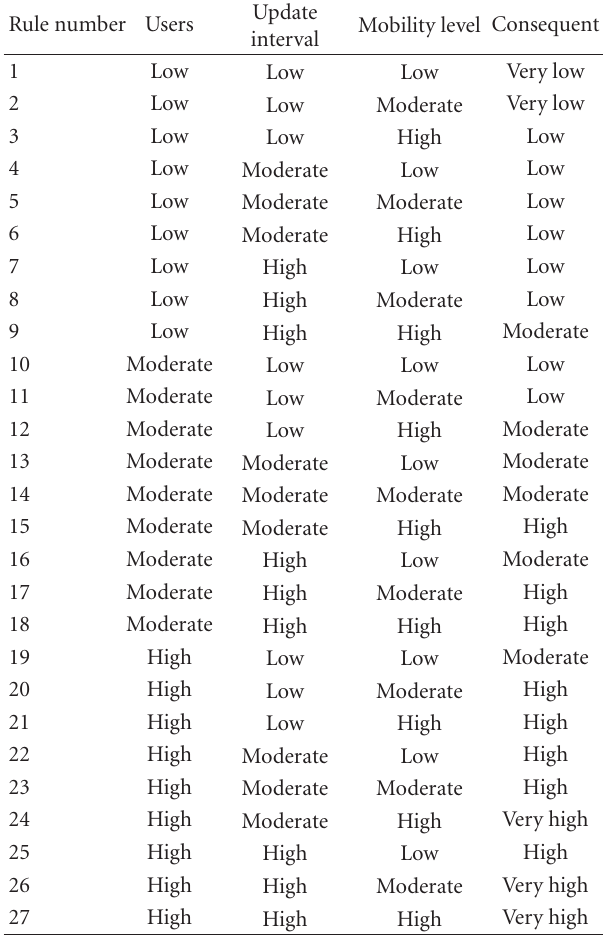
Table 1: Rules of the fuzzy